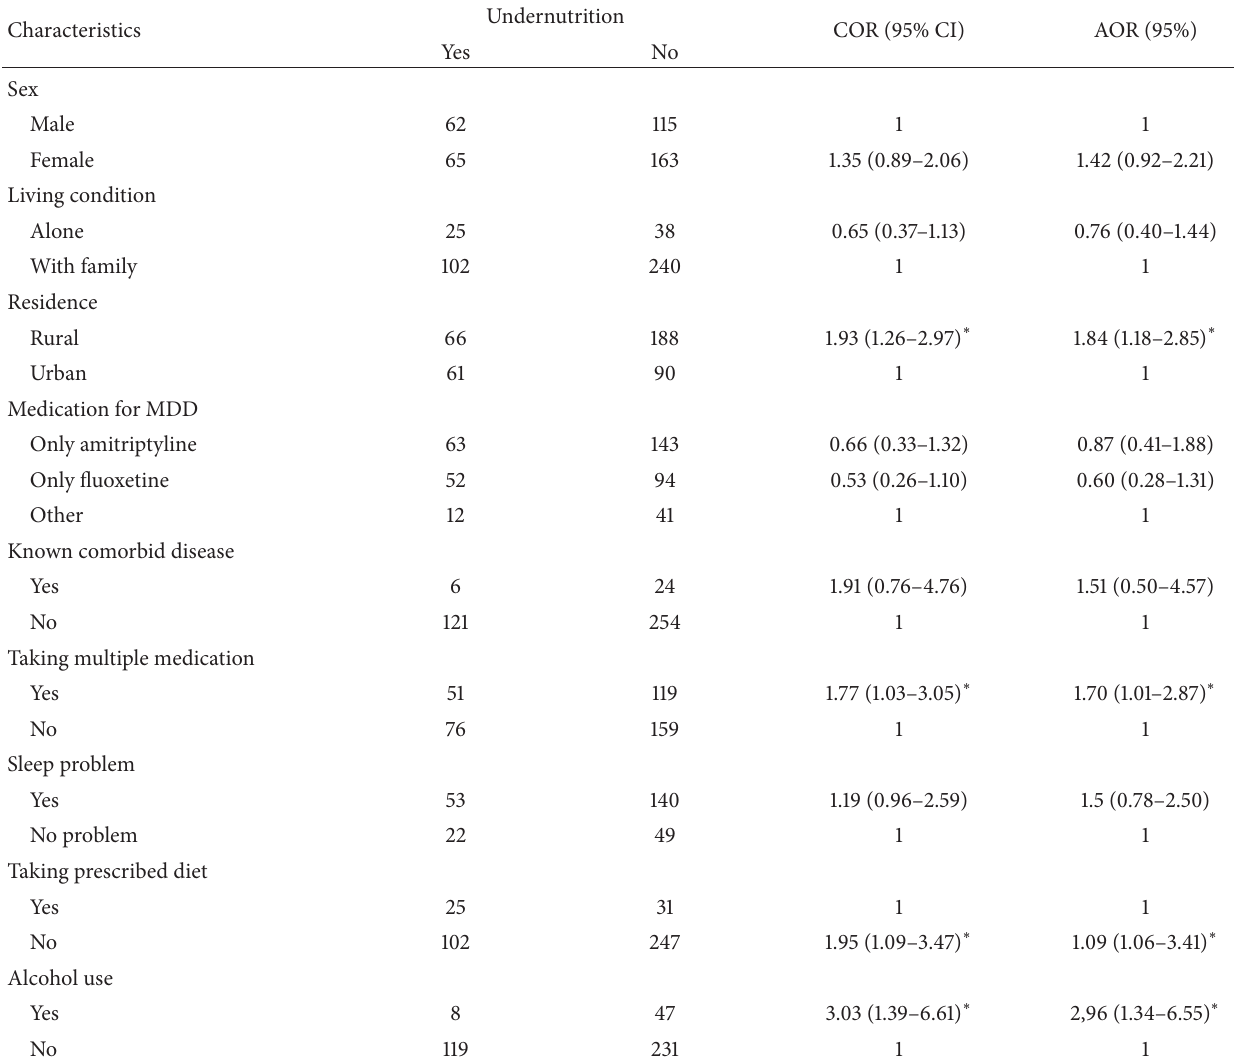
Table 4: Bivariate and multivariate analysis of factors associated with undernutrition among adults with major depressive disorder at University of Gondar Referral Teaching Hospital & Felege Hiwot Referral